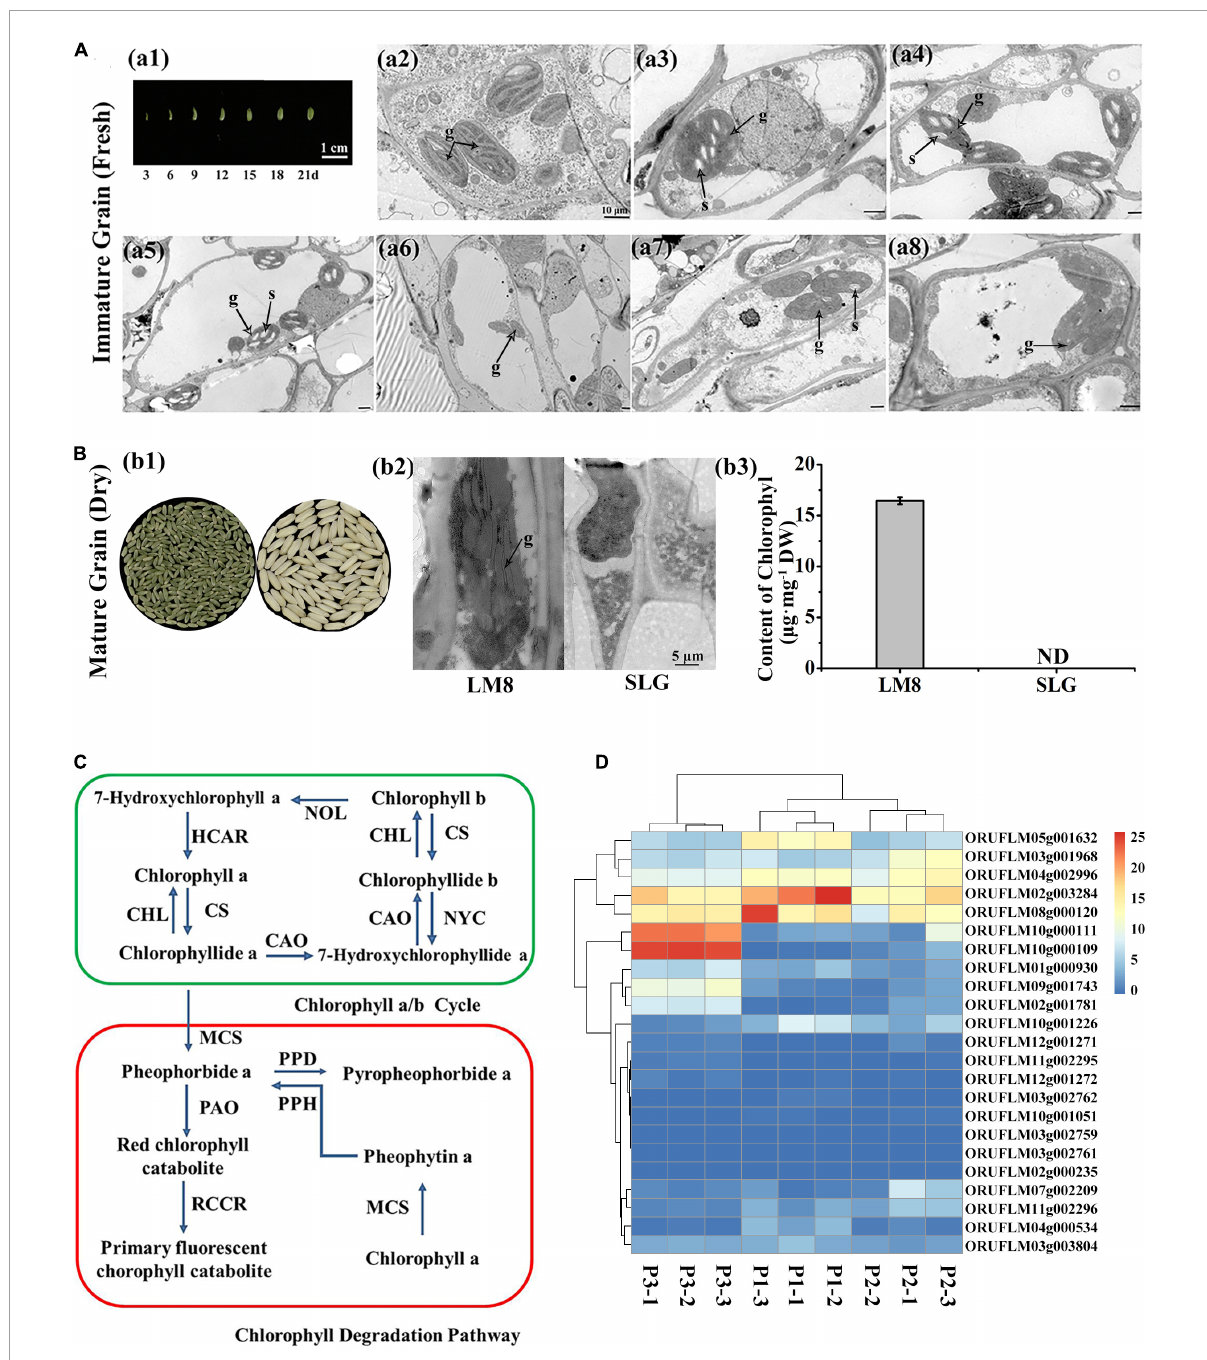
FIGURE2 Transmission electron microscopy images and a heat map of chlorophyll a / b degradation-related gene expression during the maturation of the LM8 pericarp. (A) Transmission electron microscopy image of an LM8 fresh pericarp. (a1) Developmental changes in the pericarp appearance. Numbers represent the days after flowering. (a2–a8) Chloroplast ultrastructure in different caryopsis pericarp developmental periods; g, grana; s, starch. (B) Comparison of the chloroplast ultrastructure and chlorophyll content between the LM8 and SLG dry pericarps at the fully ripe stage. (b1) Morphological differences associated with pericarp colors. (b2) Chloroplast ultrastructure. (b3) Comparison of chlorophyll contents. (C) Proposed model for the chlorophyll cycle and chlorophyll degradation. (D) Chlorophyll a / b degradation-related gene expression heat map analysis. MCS : ORUFILM04g000534, ORUFILM09g001743; PAO : ORUFILM03g002761, ORUFILM03g002762, ORUFILM03g001968, ORUFILM02g001781, ORUFILM03g002759; CAO : ORUFILM10g000111, ORUFILM10g000109; NYC : ORUFILM02g003284, ORUFILM01g000930, ORUFILM03g003804; PPD : ORUFILM11g002295, ORUFILM12g001272, ORUFILM08g000120, ORUFILM07g002209, ORUFILM11g002296, ORUFILM12g001271; RCCR : ORUFILM10g001226; CS : ORUFILM02g000235, ORUFILM10g001051; CHL : ORUFILM05g001632; HCAR :